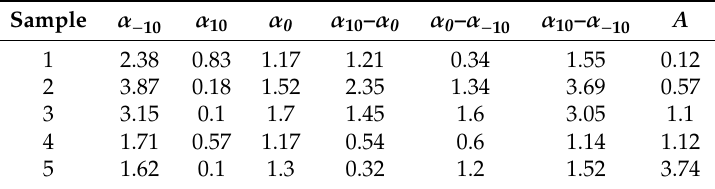
Table 4. The singularity parameters of